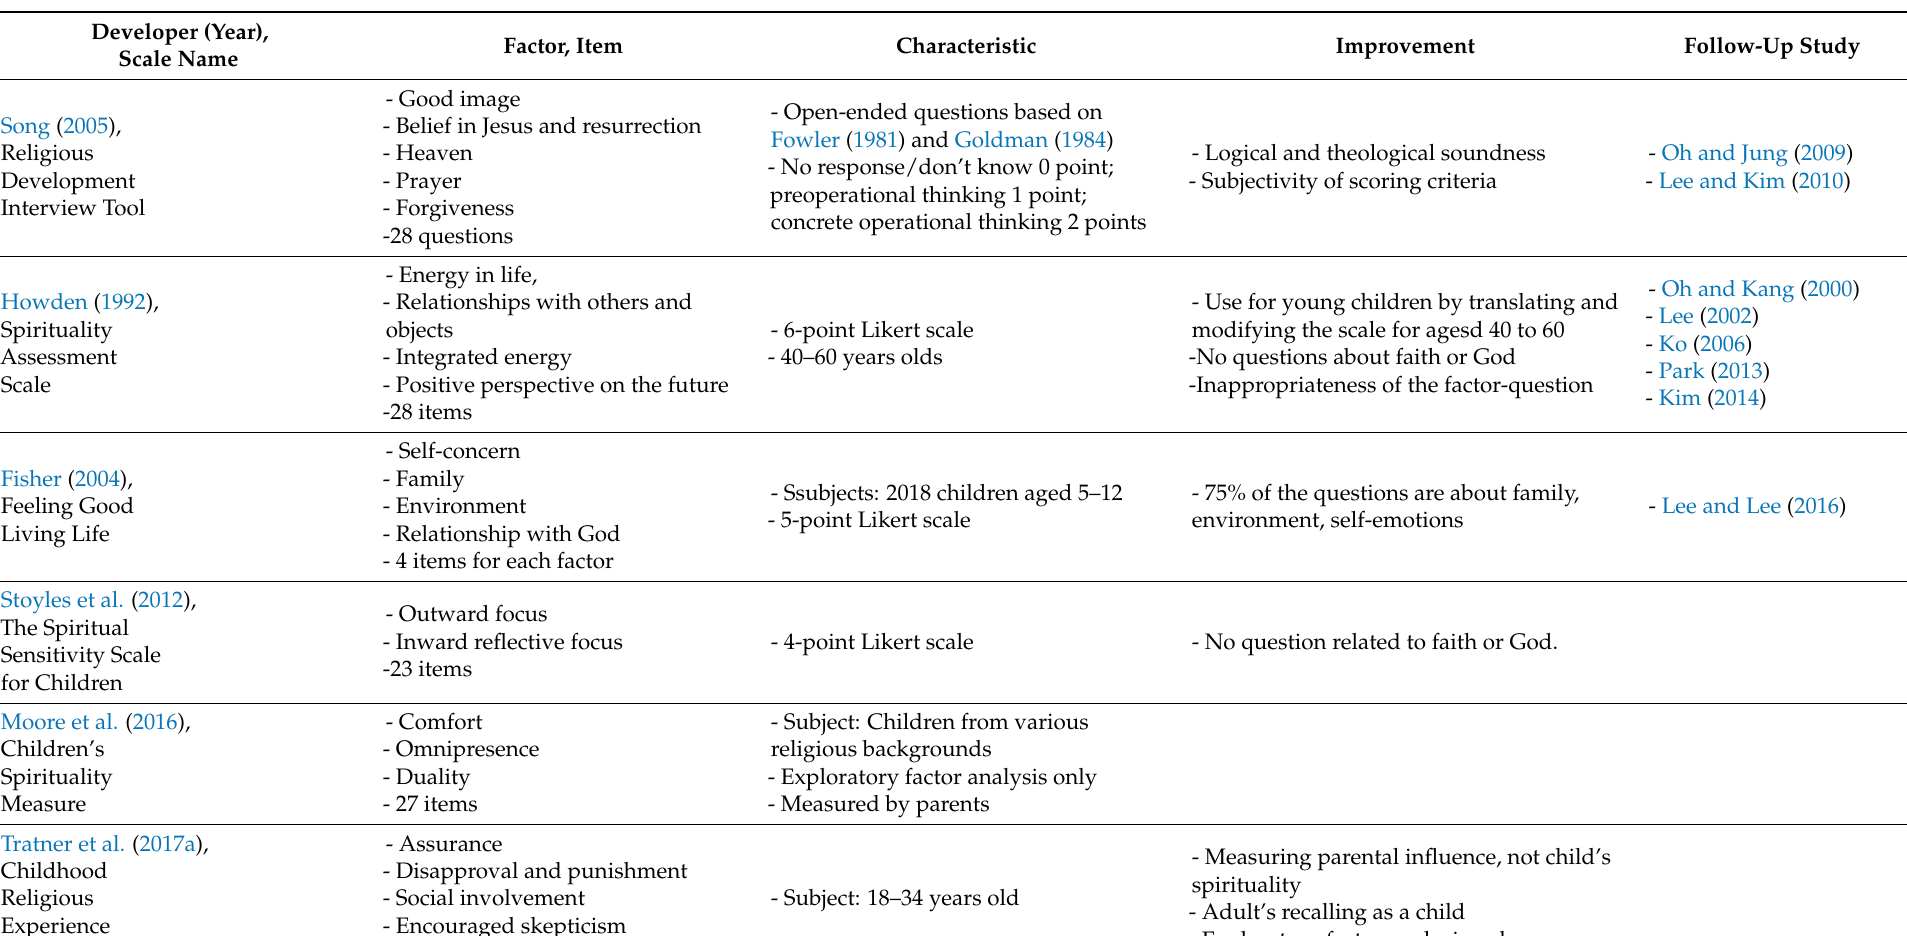
Table 1. Spirituality/faith scales for